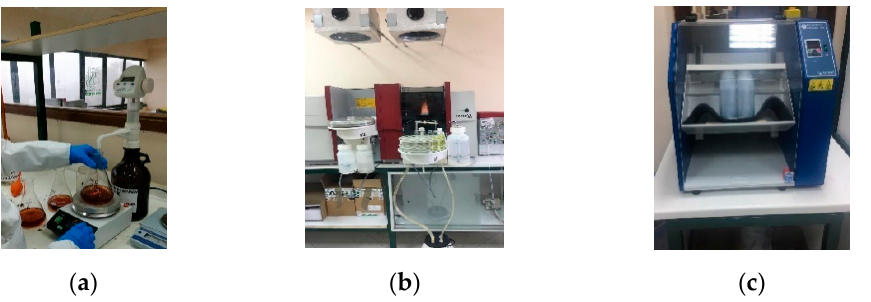
Figure 4. Leaching test: ( a ) COD titration, ( b ) APAT CNR IRSA 5130 Man. 29/03, and ( c ) agitation device.